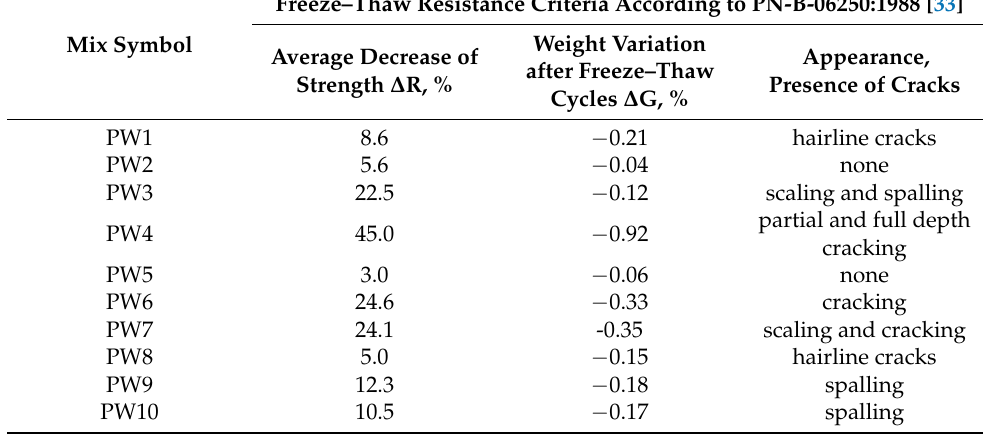
Table 5. Results of the F100 freeze–thaw test carried out on the tested concrete mixes. Freeze–Thaw Resistance Criteria According to PN-B-06250:1988 Mix Symbol